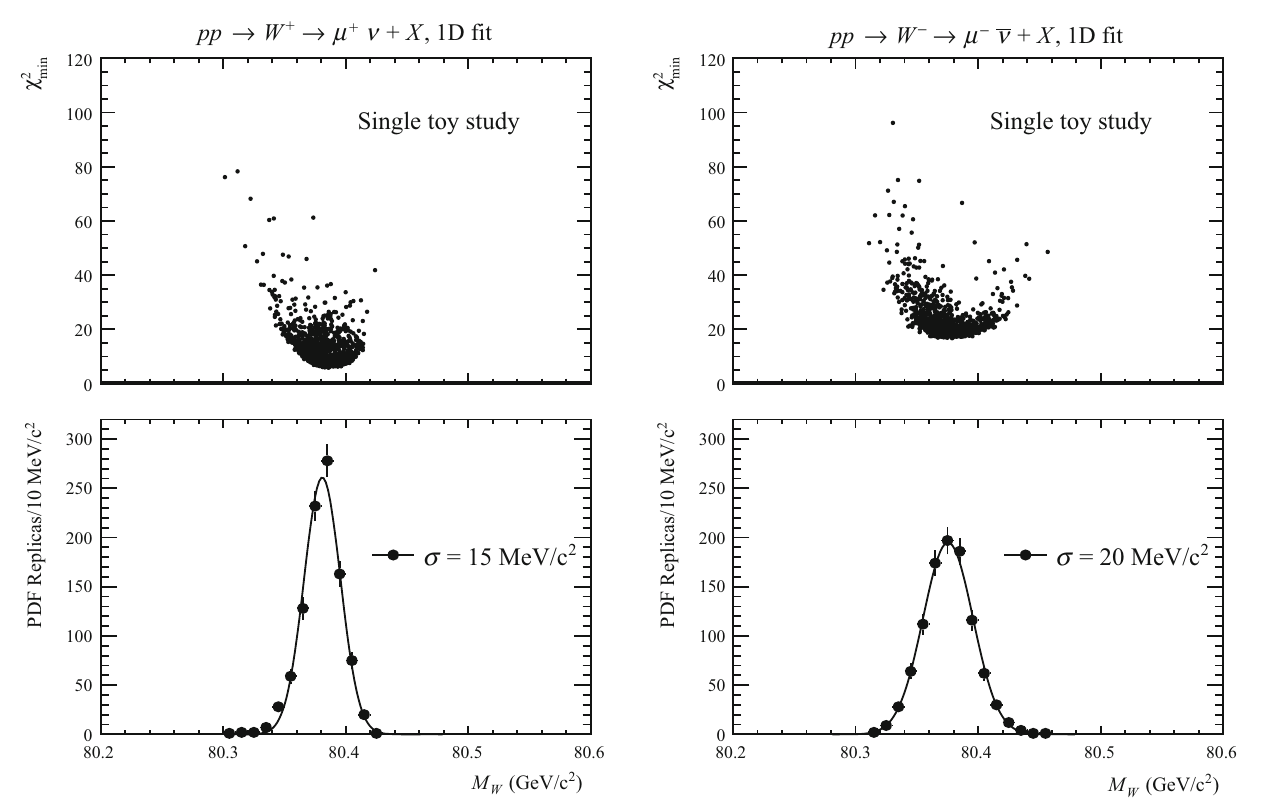
Fig. 2 Upper: the distribution of the χ 2 versus M W for a fit to a single toy dataset, which assumes the LHCb Run 2 statistics, with each of the 1000 NNPDF3.1 replicas. Lower: the distribution of the M W values with a Gaussian fit function